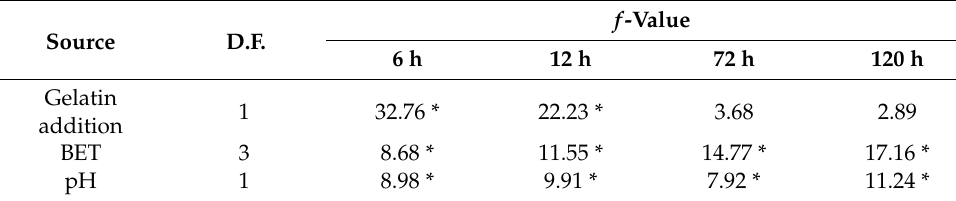
Table 1. ANOVA analysis for drug release behaviors against various